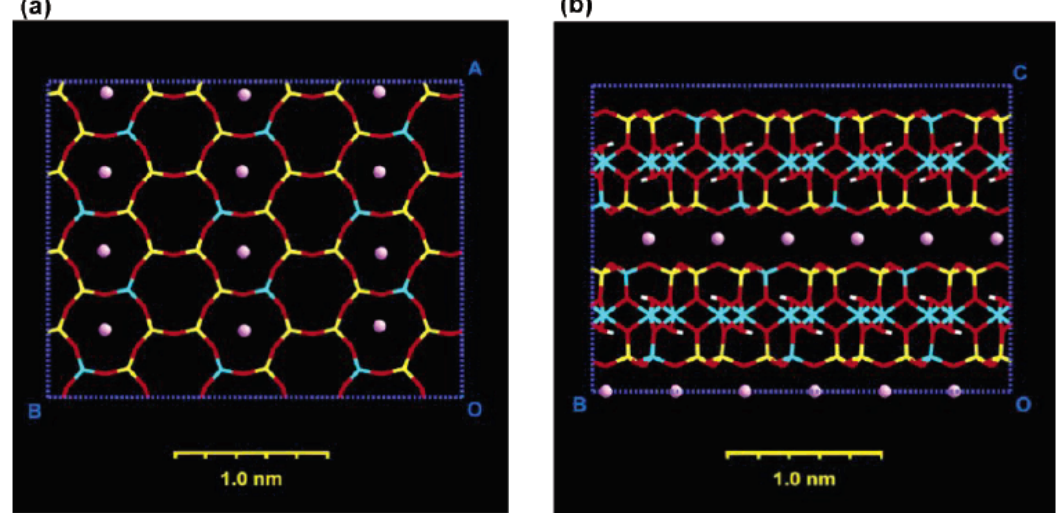
Figure 4. A simulated representation of mica unit cells. Al atoms are depicted in blue, Si in yellow, O in red, H in white, and K (or Li) ions in violet. (a) Top view showing only the upper tetrahedral layer and (b) side view showing that the cavities in the lamellae are fully occupied with alkali ions and stacked on each other. Reproduced from reference [42] with permission from American Chemical